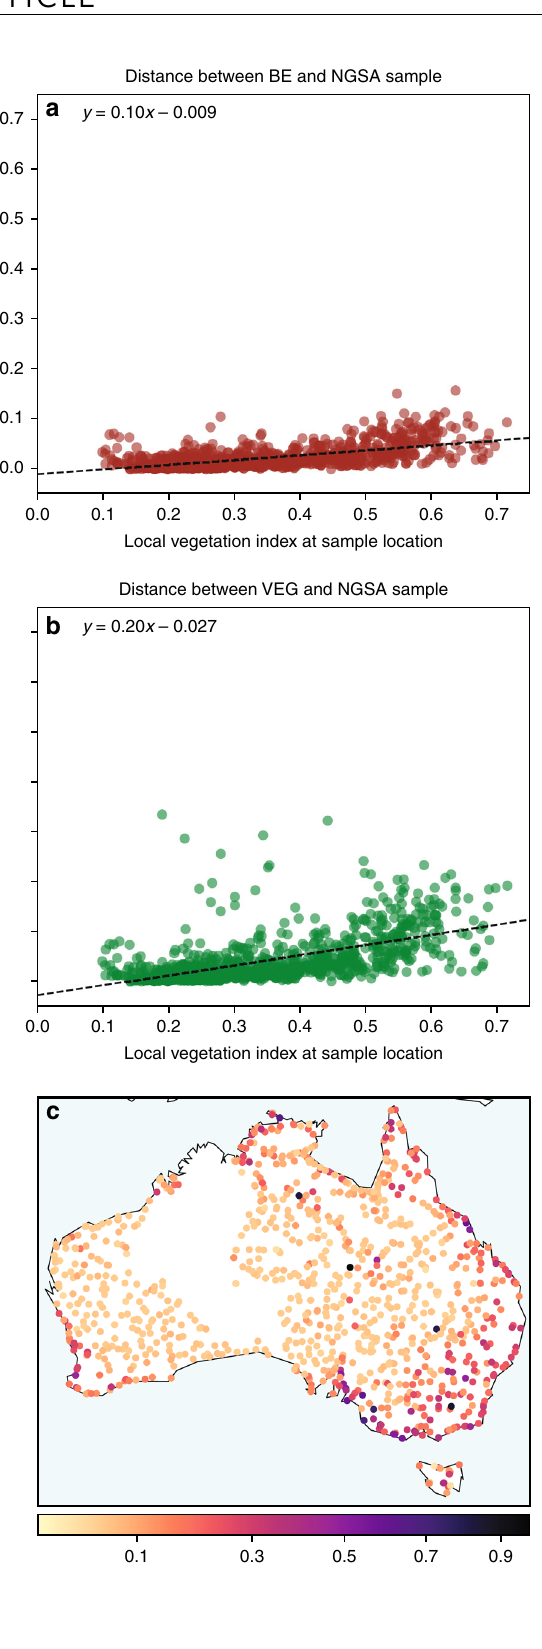
(e.g. relationships between bands) is maintained across all wave- lengths. This makes possible the extraction of mineral features based on their spectral signatures using well-established band ratios and principal component analysis 11,17,40 , or to apply machine learning algorithms for automated classi fi cation of mineralogy in the observed